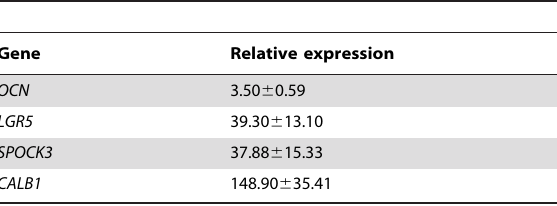
Table 5. mRNA expression ratios for permanent/deciduous dental pulp tissues.